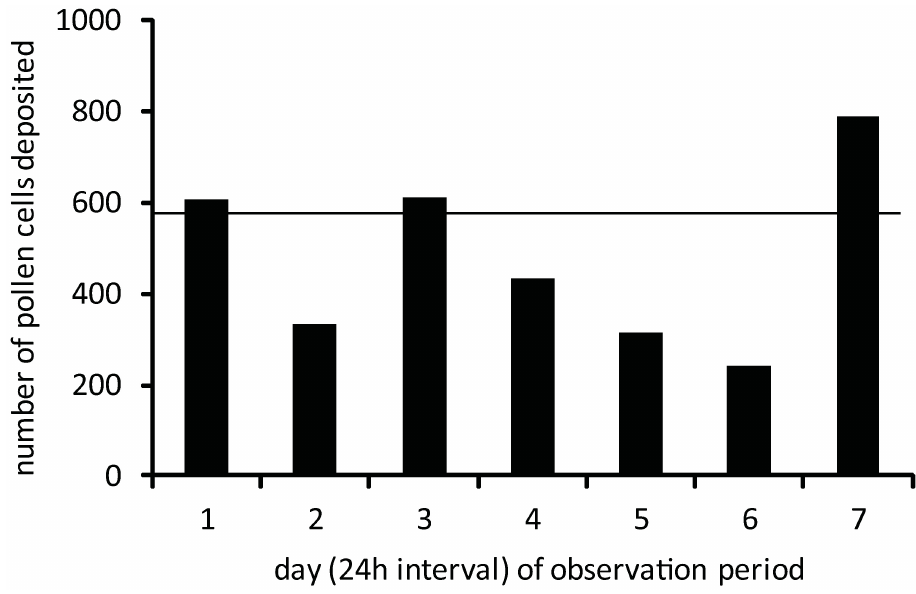
Fig 1. Total number of new stored pollen cells formed daily in six colonies during the 8d frame monitoring period. The line indicatesthe averagenumberof new stored pollencells depositeddaily in all coloniesover the 8d observation